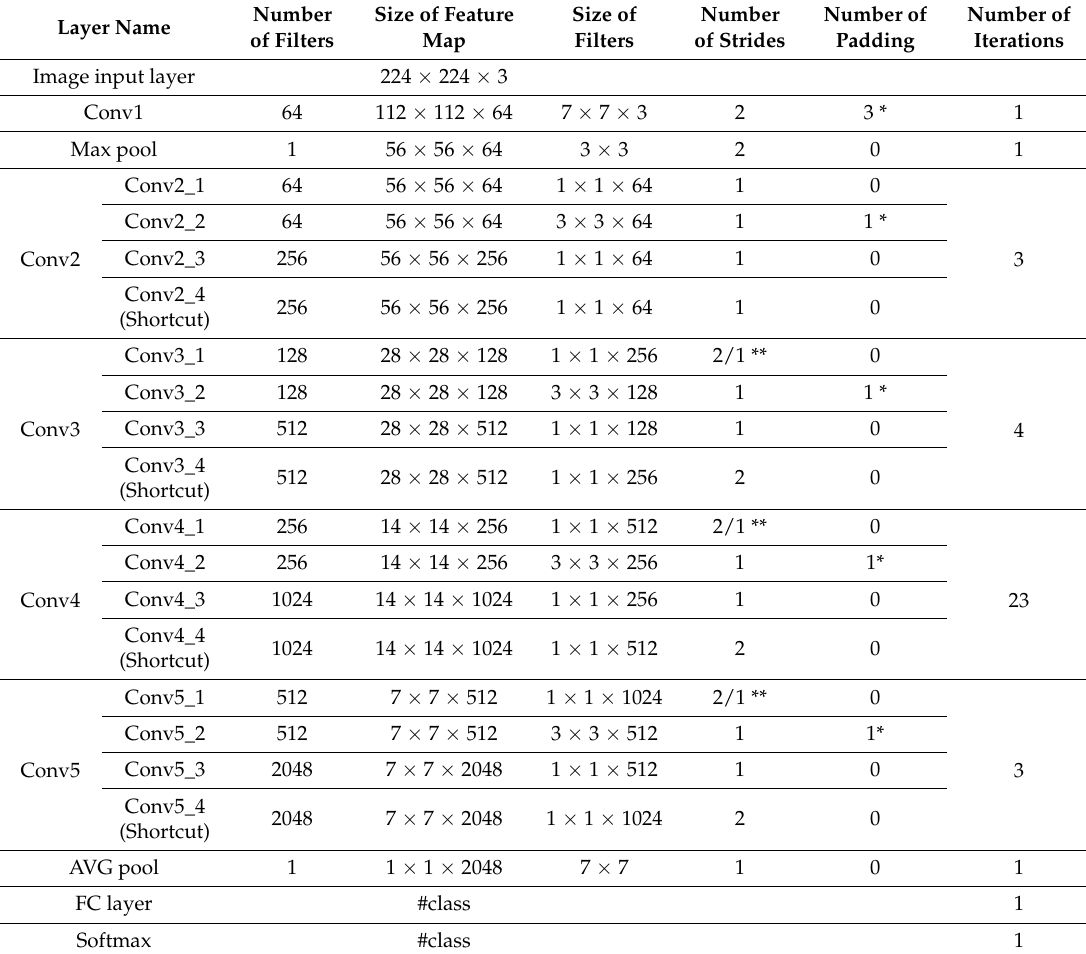
Table 2. The proposed CNN configuration used in our research (3 * indicates that three pixels are included as padding in, respectively, the left, right, up, and down positions of an input image of 224 × 224 × 3 pixels, whereas 1 * means that one pixel is included as padding in the left, right, up, and down positions of the feature map) (2/1 ** means 2 at the first iteration and 1 from the second iteration) (in finger-vein recognition, #class is 2, and in finger shape recognition, it indicates the class number of the learning